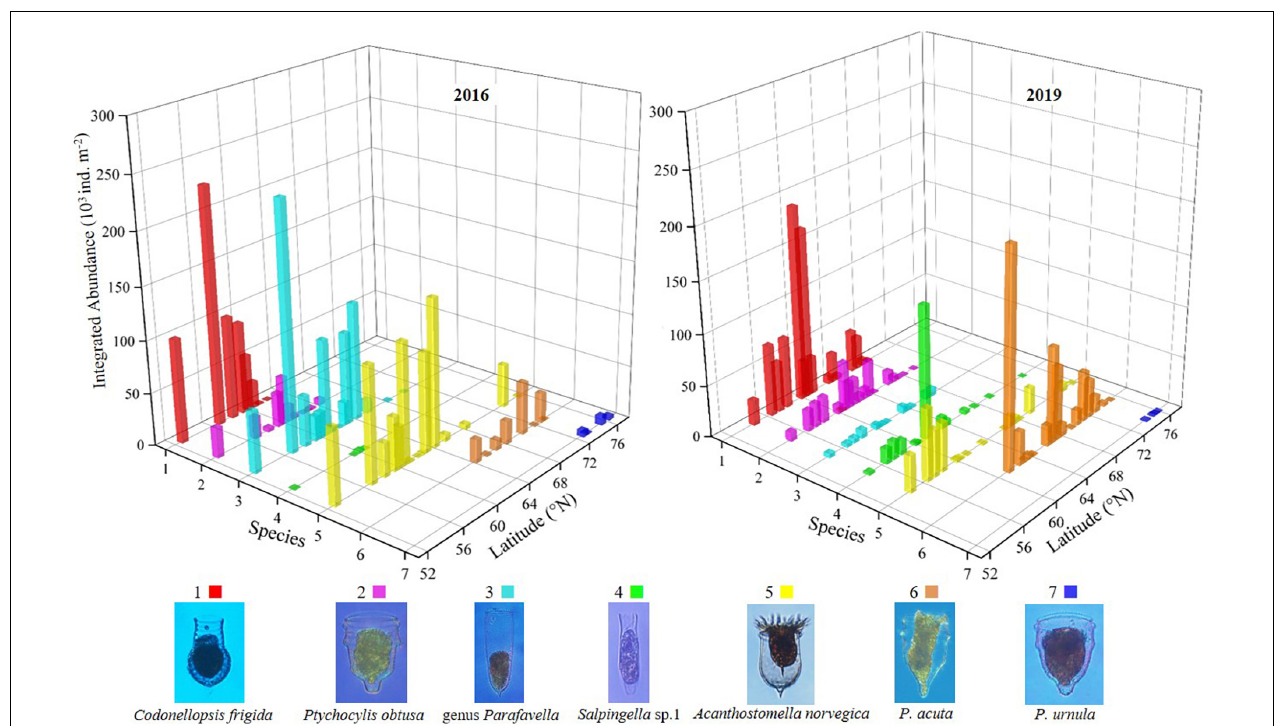
FIGURE 6 | Latitudinal distribution variation of dominant oceanic tintinnid integrated abundance.